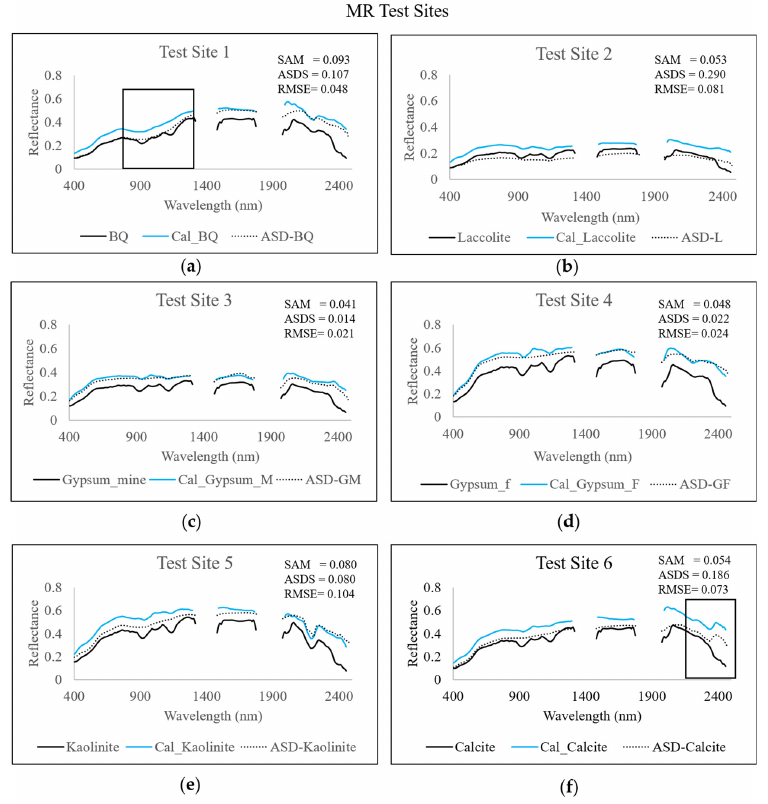
Figure 14. The MR test sites of PRISMA original (before calibration) reflectance (black line) against corrected reflectance (after applying the SBAF, blue line), and the field ASD spectra (dashed black line); ( a ) brown questa (BQ), ( b ) laccolite, ( c ) gypsum mine, ( d ) gypsum fans, ( e ) kaolinite, ( f ) calcite.